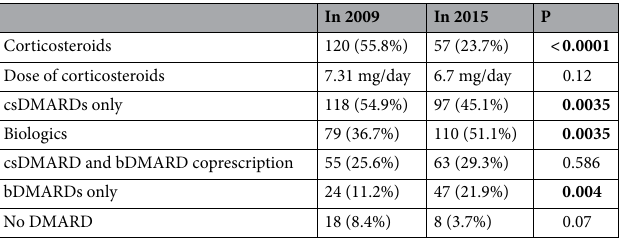
Table 2. Rheumatoid arthritis treatment prescribed in patient follow-up until 2015 (n = 215). Significant values are in bold.